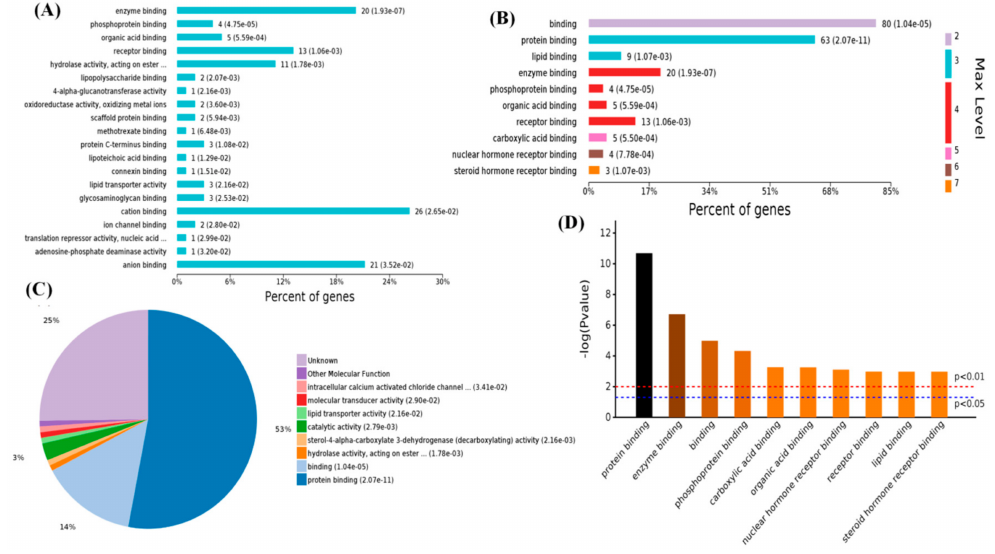
Figure 5. Enriched molecular functions of 119 differential proteins in high-melatonin groups. ( A ) Levels of enriched molecular functions. ( B ) Significantly enriched molecular functions (top 10). ( C ) Expressed proteins of enriched molecular functions. ( D ) Significantly enriched molecular functions with p